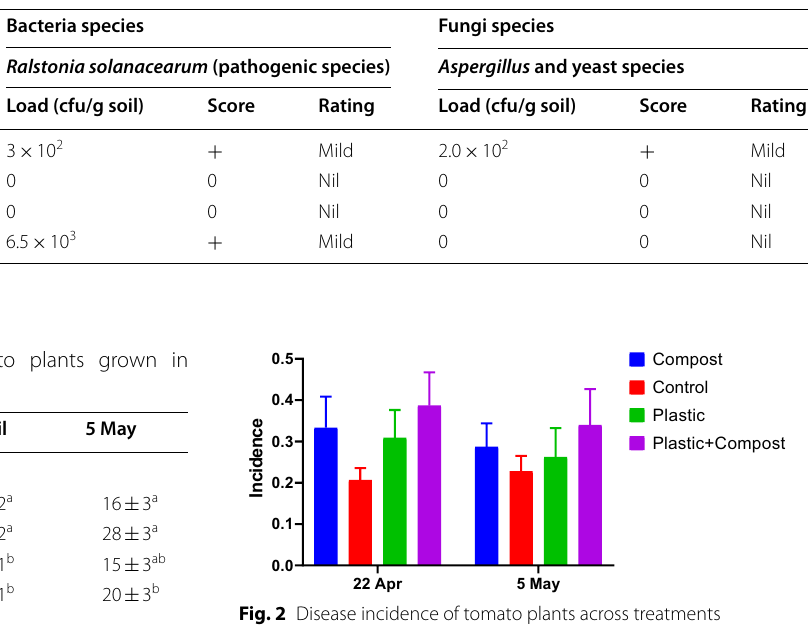
Table 5 Occurrence of wilt pathogens (bacteria and fungi) in post-solarized soil